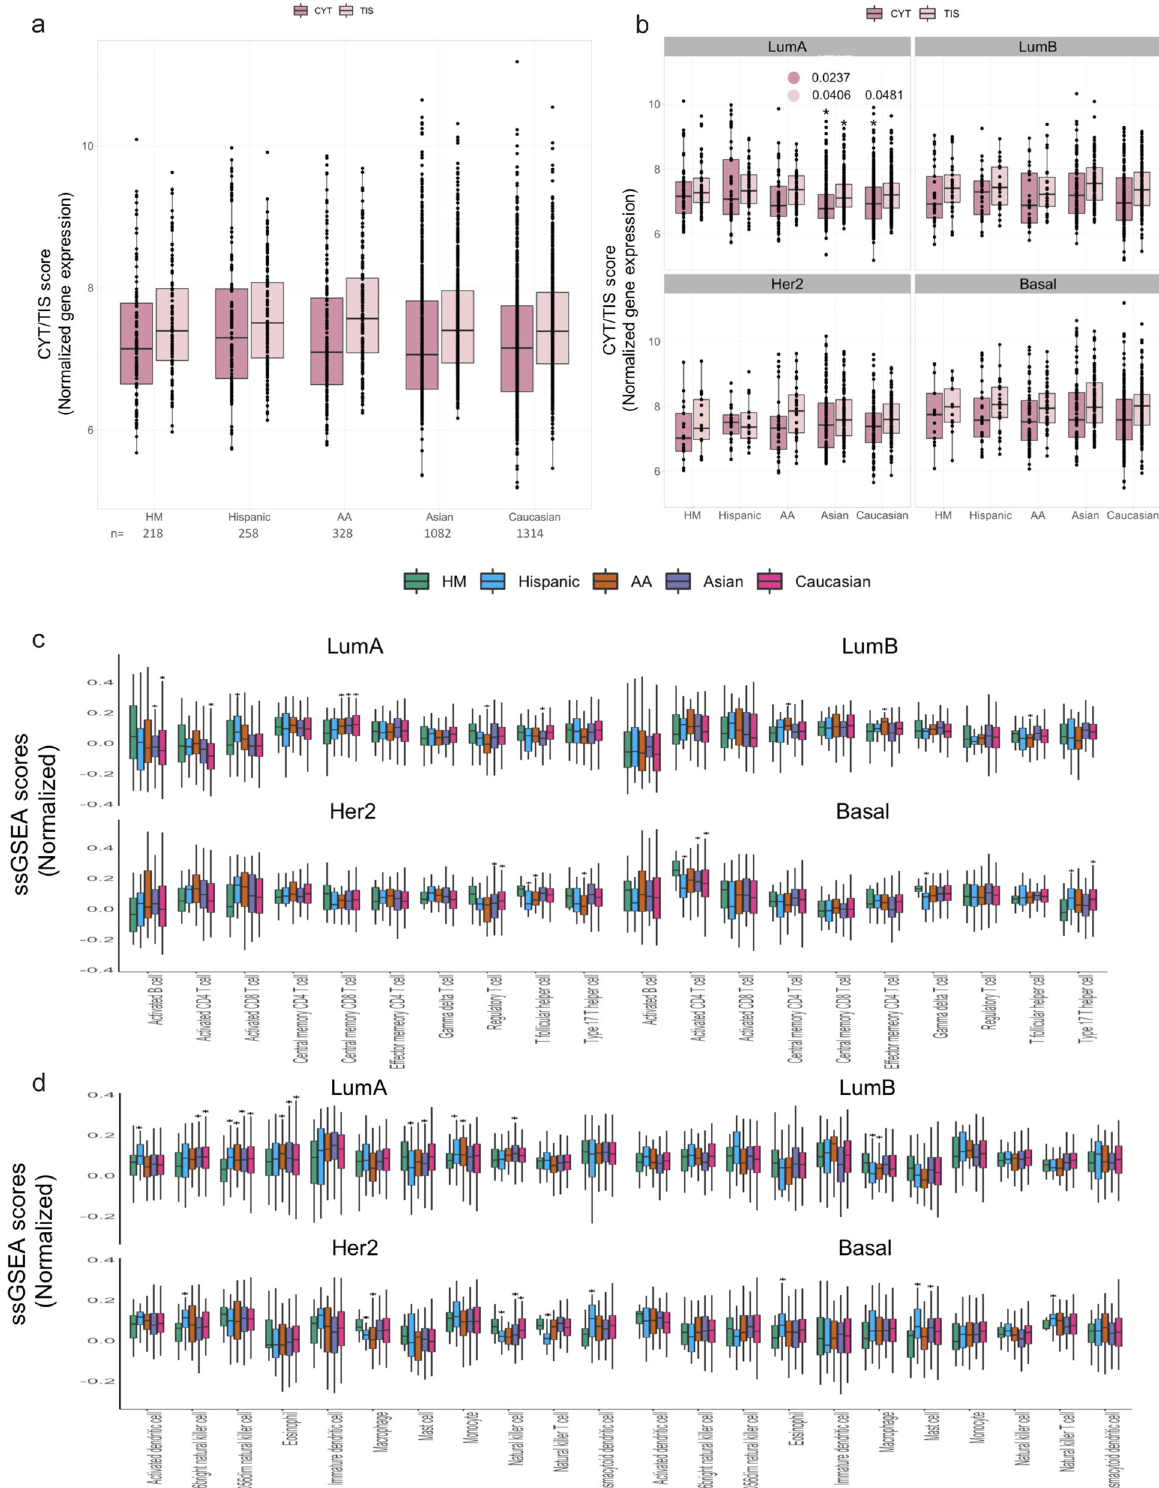
Fig. 8 Immune landscape of breast cancer tumors. a Boxplots showing the overall distribution of CYT and TIS scores across breast cancer samples and ancestries. b Boxplots describing the distribution of CYT and TIS score among PAM50 intrinsic subtypes in each ancestry-group. p -values are indicated near the corresponding asterisks in accordance to color legend (Purple: CYT and pink: TIS). Barplot showing the distribution of immune-cell population signature scores (ssGSEA) of c adaptive and d innate immune cells across PAM50 subtypes and ancestries. Statistical comparison based on two-tailed Wilcoxon sum of ranking test taking HM group as reference. Boxplots in panel a – d represent median± IQR (25th and 75th percentile) and whiskers correspond to maximum and minimum values. BH-adjusted p -value* < 0.05. Statistics from panel c and d are described at supplementary data 10. HM: Hispanic-Mexican, AA: African-American, LumA: Luminal A, LumB: Luminal B, CYT: cytolytic activity score, TIS: Tumor in fl ammation signature.